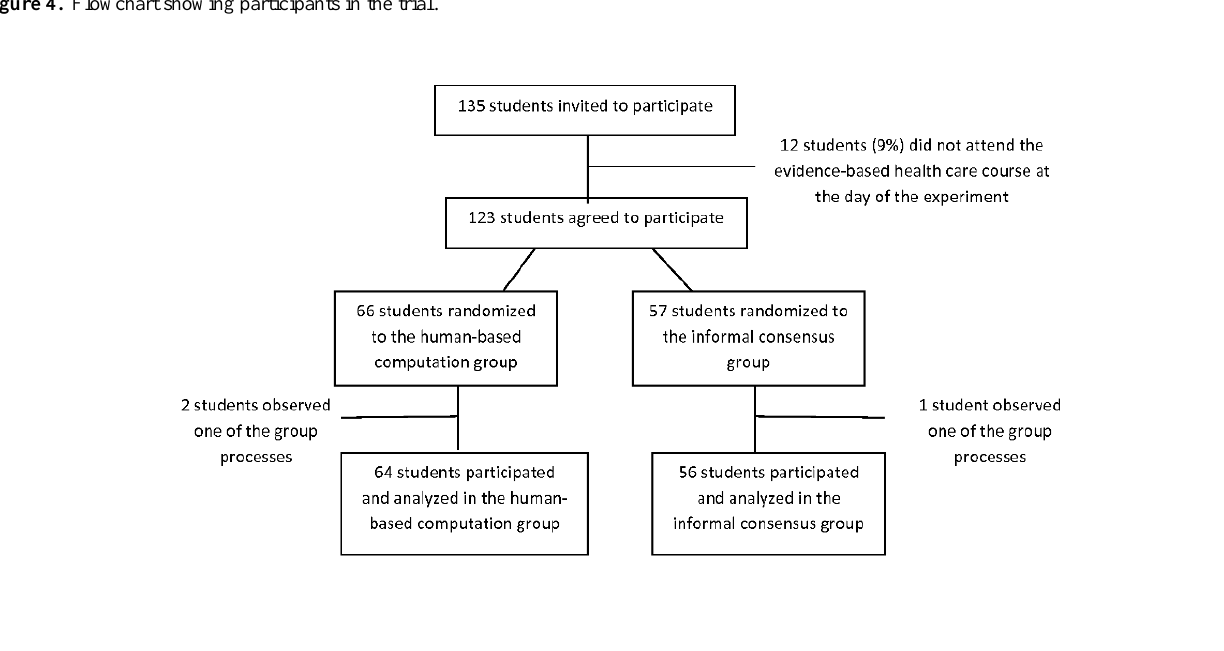
Figure 4. Flowchart showing participants in the